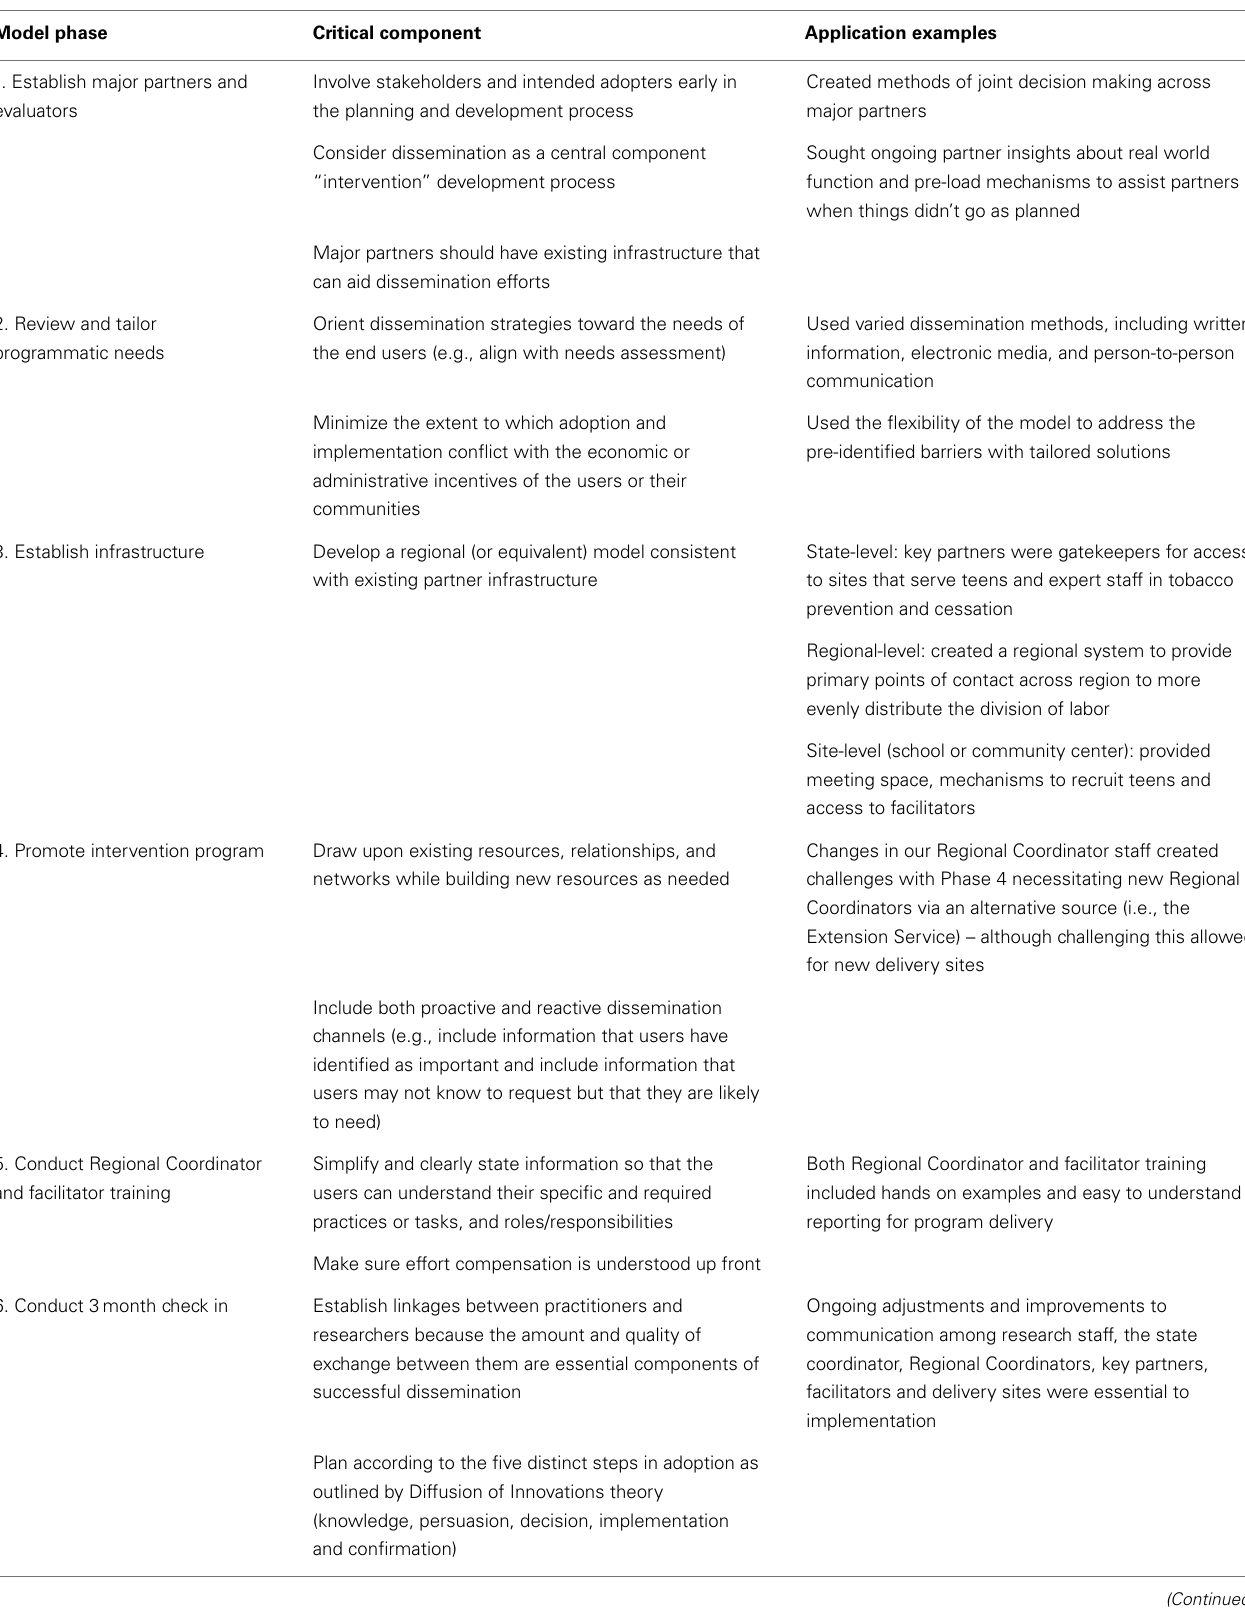
Table 1 |Application of model phases